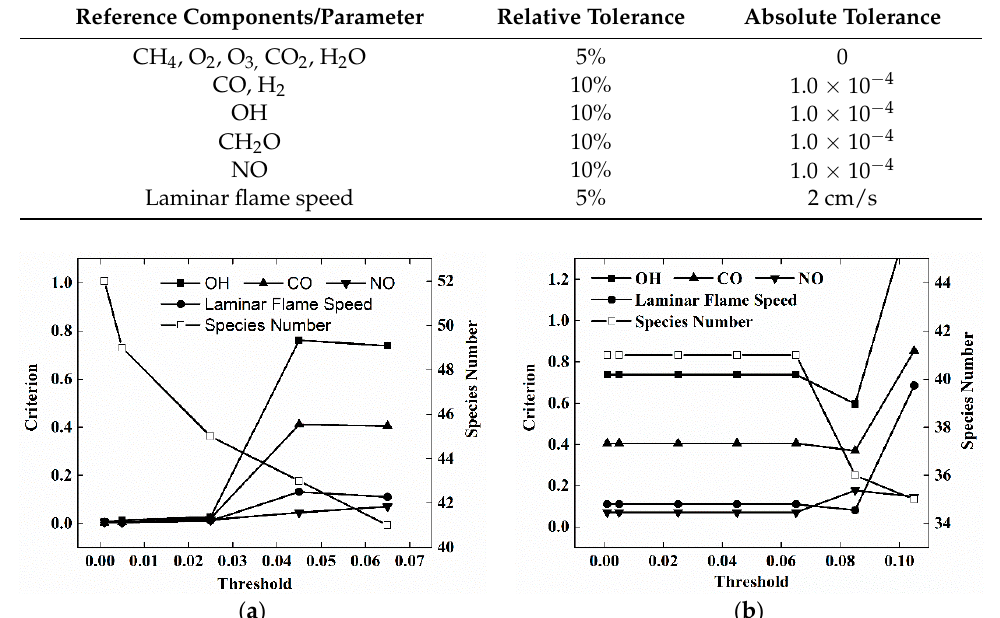
Figure 3. Variations in criterions and components with respect to threshold. ( a ) First iteration; ( b ) Second iteration.